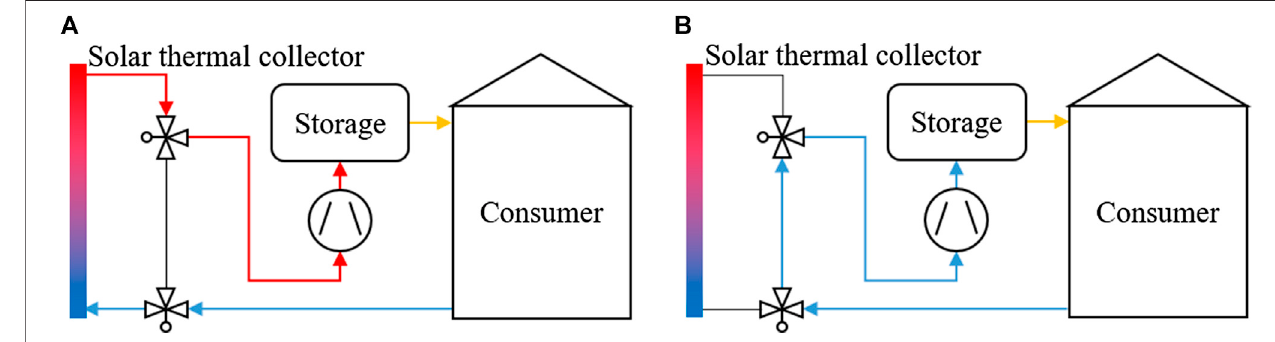
FIGURE 1 | Operation modes of a possible latent heat storage system: charging during the day (A) and discharging during the night (B)